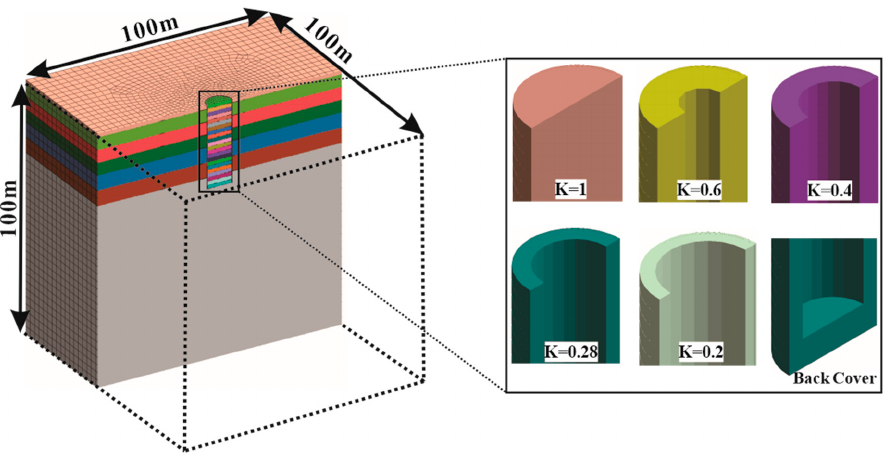
Figure 16. Numerical model.